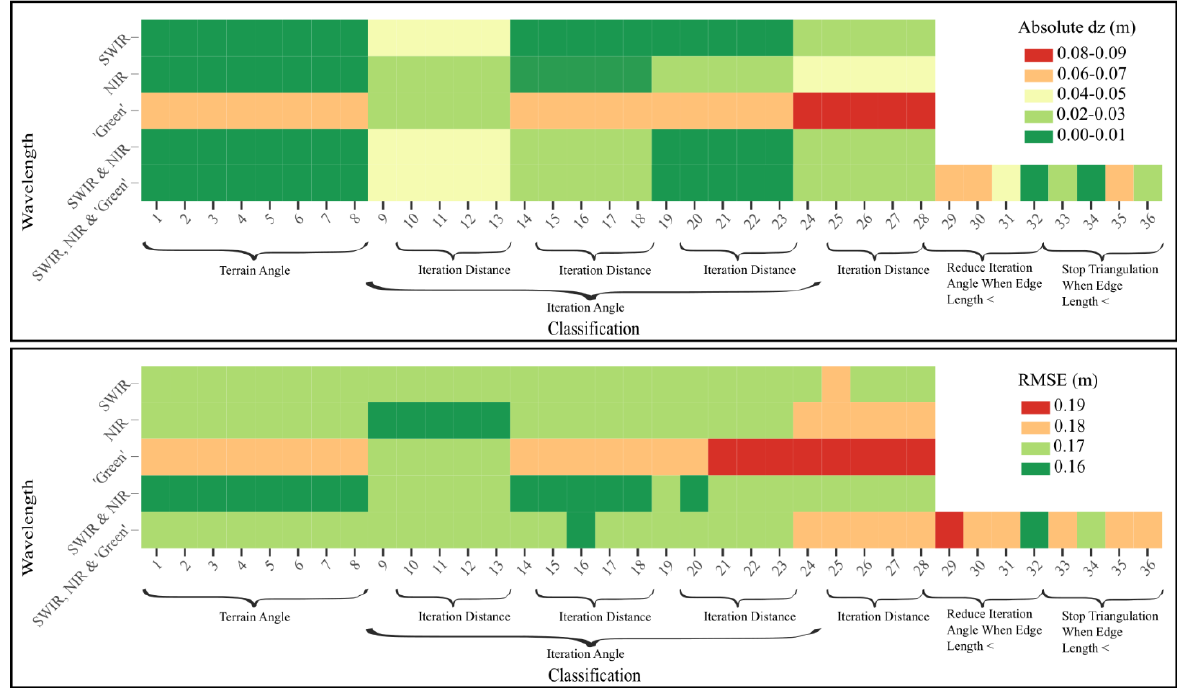
Figure 10. Ground classification results (| dz | and RMSE) in burned peatlands with tall vegetation regeneration two years post-fire (as a proxy for 3+ years post-fire). Classifications were conducted in TerraScan.